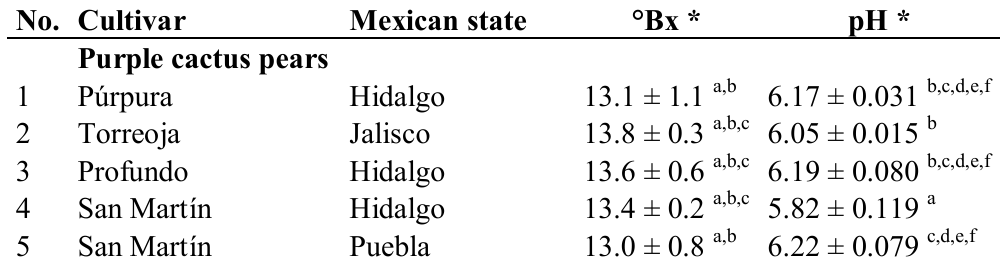
Table 1. Description of 18 cultivars of cactus pear from six Mexican states. * Data with the same lowercase letter are not significantly different ( p <